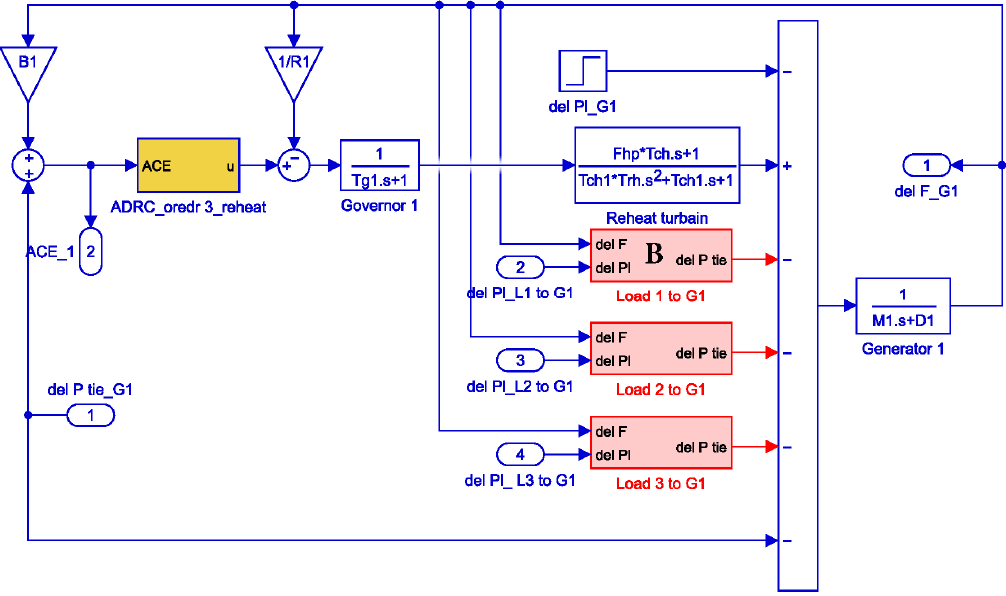
Figure 6. Dynamic model of power plant 1 (block A in Figure 5).